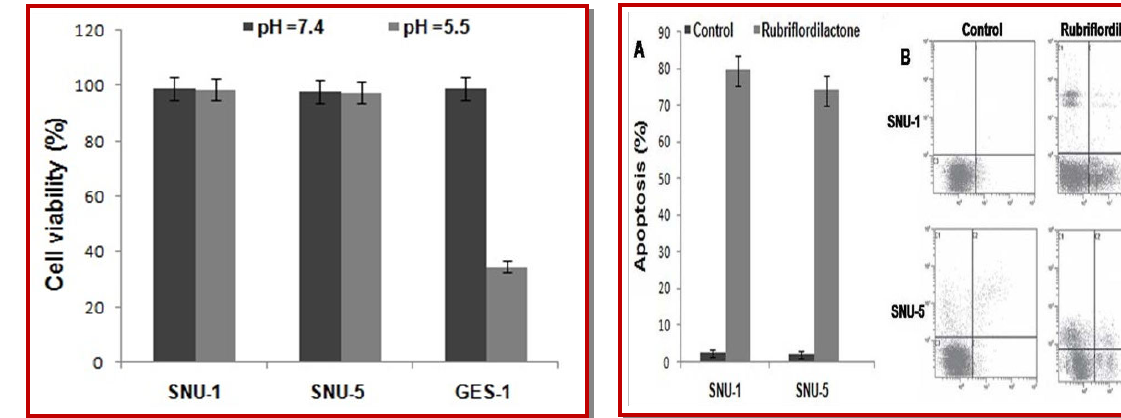
Figure 4: Effect of rubriflordilactone A on induction of apopto- sis in SNU-1 SNU-5 and cancer cell line after 48 hours